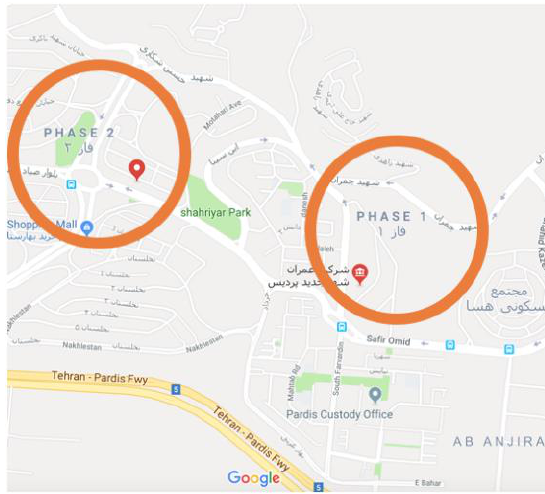
Figure 3: Pardis Mehr housing outside of the city (URL 2)